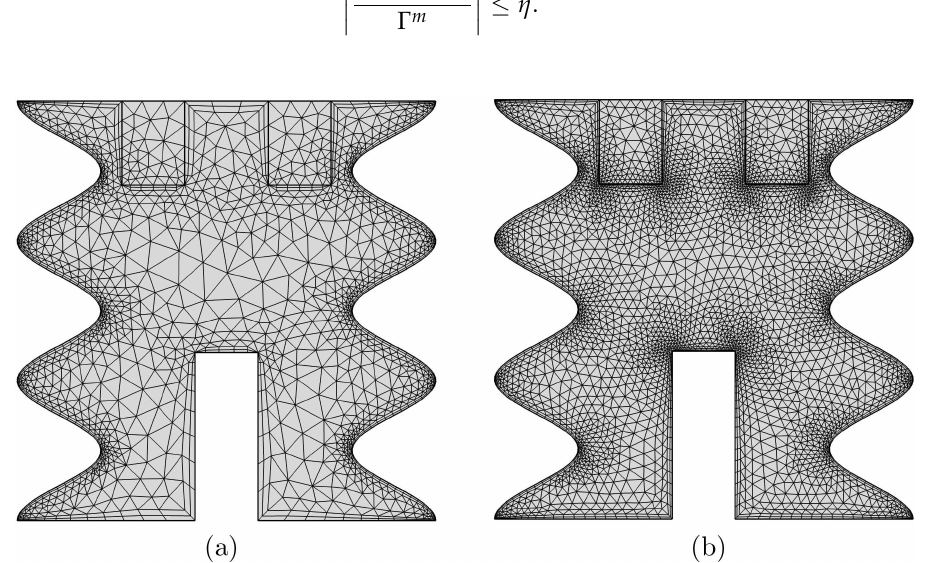
Figure 2. Sample meshes used for grid study: ( a ) 2868 elements and ( b ) 7115